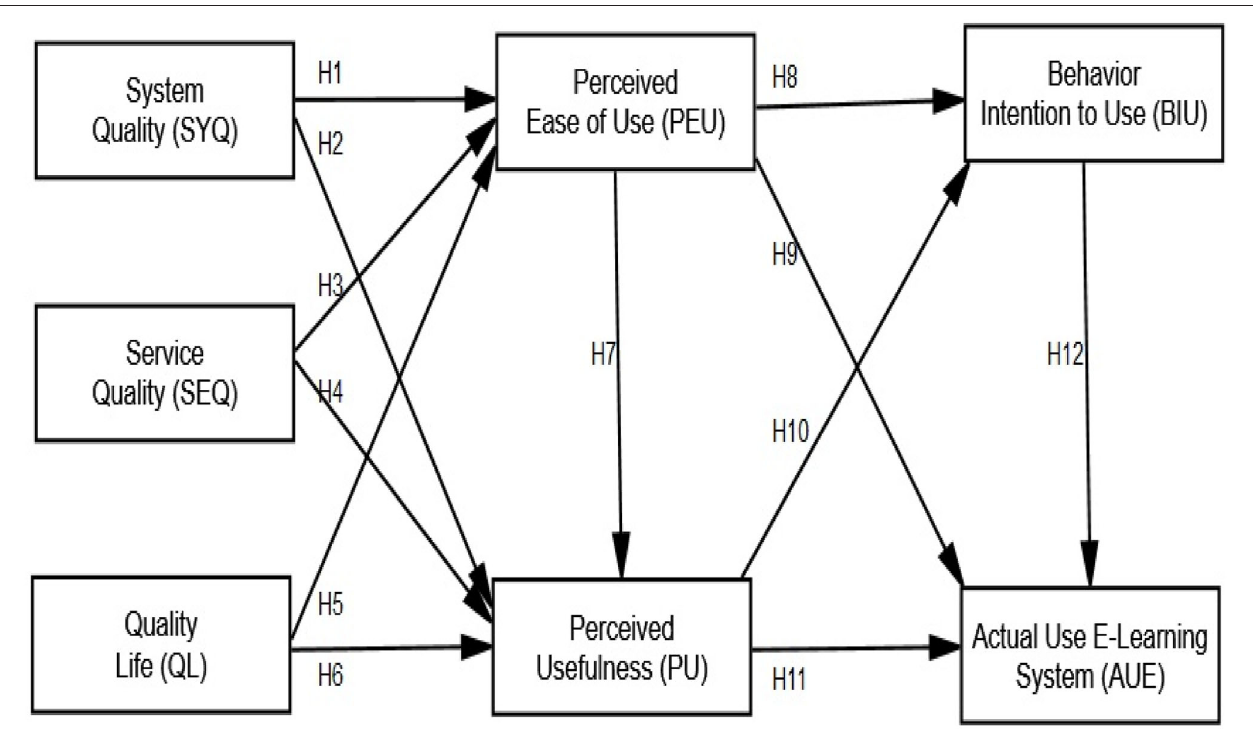
FIGURE 1 | Research